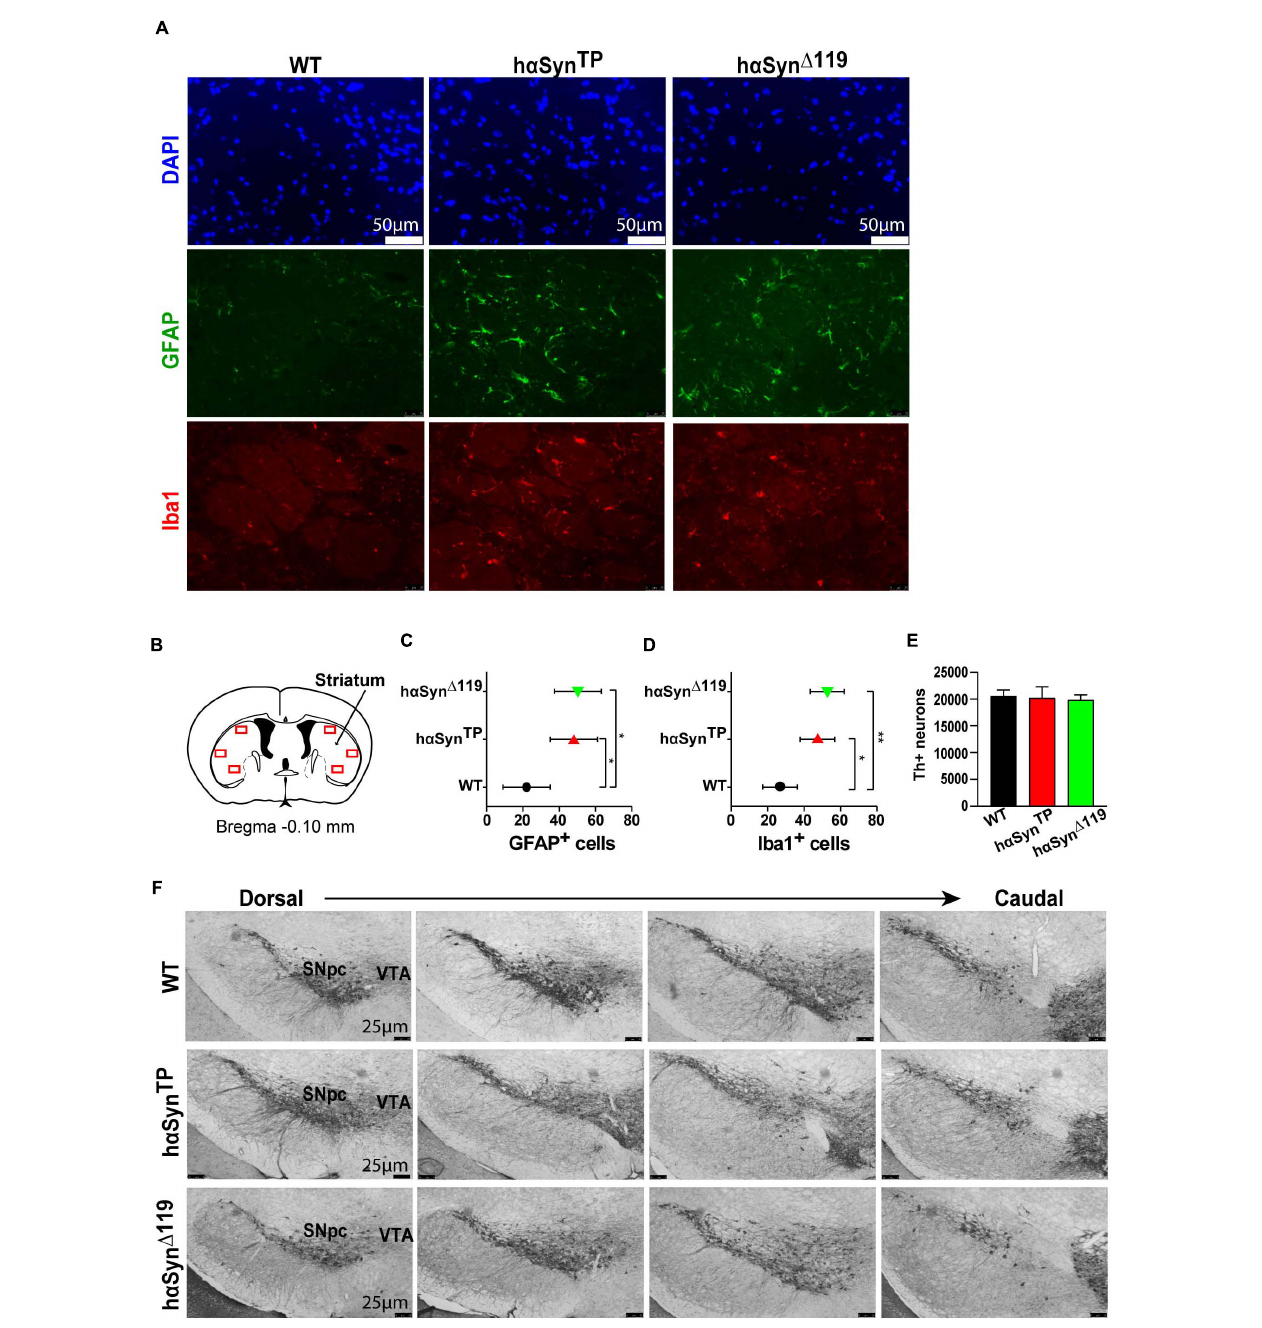
FIGURE 2 | Active neuroinflammatory response in 1.5 years old h α Syn TP and h α Syn (cid:49) 119 mice but no apparent loss of DAergic neurons of the substantia nigra. (A) Representative coronal sections through the striatum from perfused WT, h α Syn TP and h α Syn (cid:49) 119 mice immunostained with GFAP (green) and Iba1 (red) showed more GFAP + and Iba1 + cells in h α Syn TP and h α Syn (cid:49) 119 mice. DAPI shows nuclei in blue. (B) Striatal regions (red rectangles, 3 regions per hemisphere) selected for quantification of GFAP + and Iba1 + cells. Image modified from the Mouse Brain Atlas (Franklin and Paxinos, 2013). (C) Quantification of GFAP + cells in striatal coronal sections showed a significant increase of reactive astrocytes in h α Syn TP and h α Syn (cid:49) 119 mice compared to WT mice. Represented in graph are group means ± SEM. Group comparisons using Nested 1-way ANOVA with Tukey’s multiple comparisons test. * p < 0.05, ** p < 0.01. (D) Quantification of Iba1 + cells in striatal coronal section showed a significant increase of reactive microglia in h α Syn TP and h α Syn (cid:49) 119 mice compared to WT mice. Analyses as in C . (E) Stereological quantification of Tyrosine hydroxylase (Th) positive neurons in the substantia nigra of 1.5 years old mice showed a similar number of positive DAergic neurons for all groups, suggesting no neuronal loss occurs in the h α Syn TP or h α Syn (cid:49) 119 models. n = 3 per group. Comparison to WT using 1-way ANOVA with Dunnett’s multiple comparisons test. (F) Representative coronal brain sections from perfused WT, h α Syn TP and h α Syn (cid:49) 119 mice immunostained with anti-Tyrosine hydroxylase antibody, a marker for DAergic neurons in the substantia nigra pars compacta (SNpc) and ventral tegmental area (VTA). There were no apparent morphological changes in h α Syn TP or h α Syn (cid:49) 119 compared to WT mice.